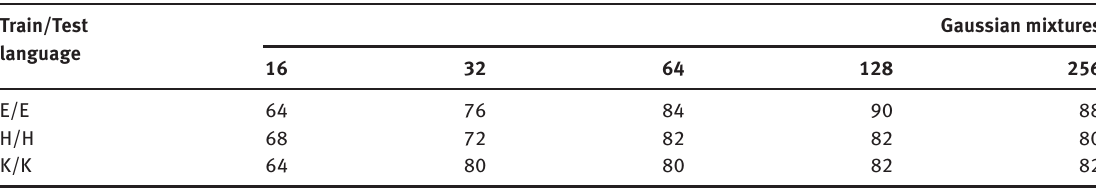
Table 4: Speaker Identification Performance (%) for the 50 Speakers of Our Own Database Using 20 s Training and Testing Data for the GMM-UBM Modeling Technique.